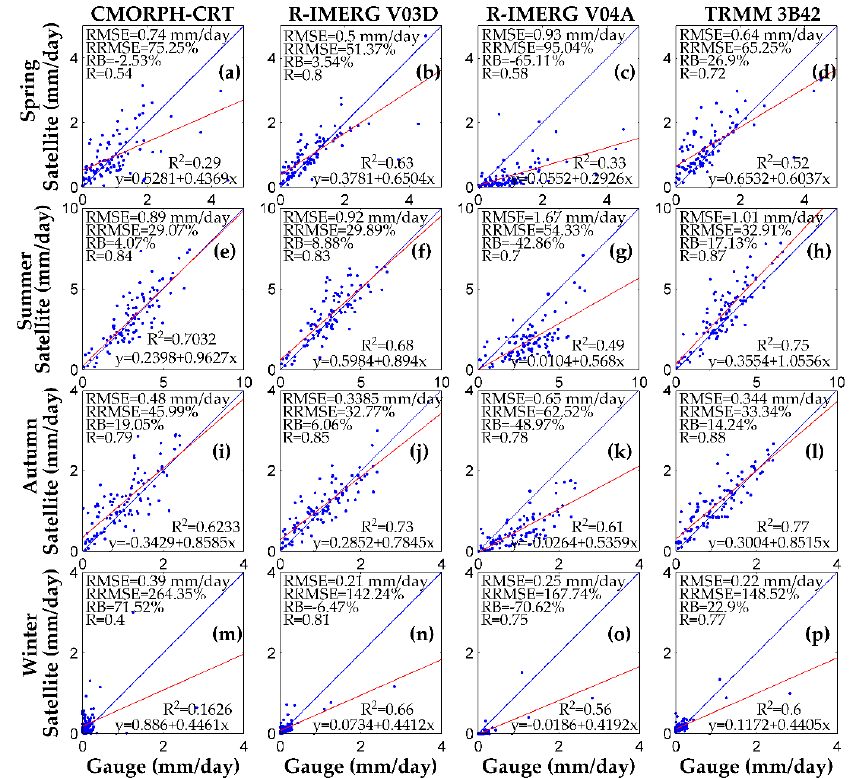
Figure 6. Scatterplots of satellite-based versus ground-based average daily rainfall estimates for the four seasons over the Tibetan Plateau for CMORPH-CRT ( a , e , i , m ), R-IMERG V03D ( b , f , j , n ), R-IMERG four seasons over the Tibetan Plateau for CMORPH-CRT ( a , e , i , m ); R-IMERG V03D ( b , f , j , n ); R-IMERG V04A ( c , g , k , o ) and TRMM 3B42 ( d , h , l , p ). V04A ( c , g , k , o ) and TRMM 3B42 ( d , h , l , p